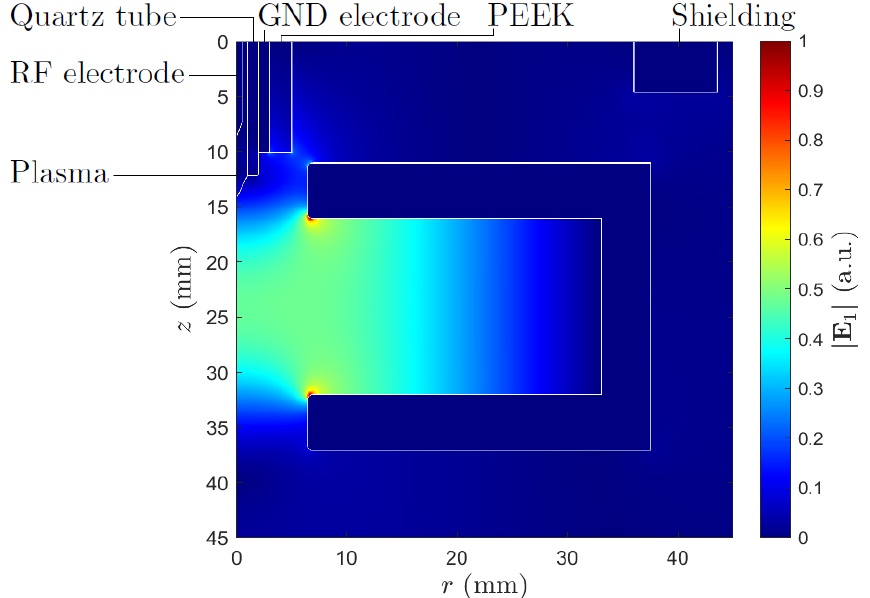
Figure 6. The electric field magnitude of the TM 010 mode inside and in the vicinity of the